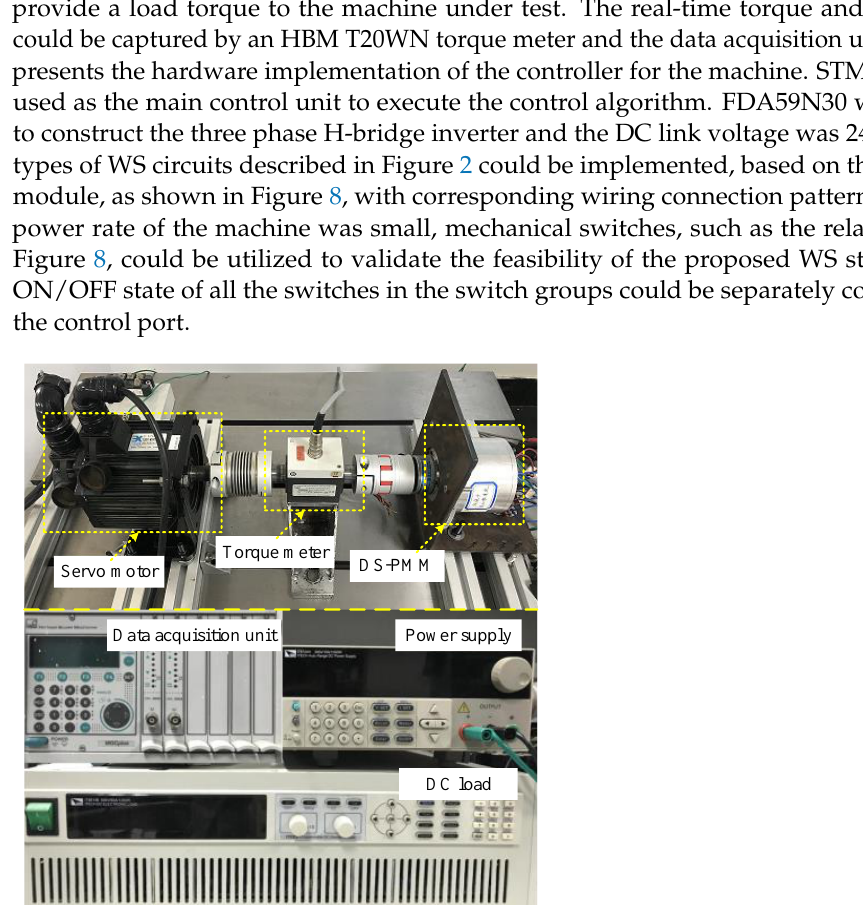
Figure 8. The controller of the investigated DS-PMM using WS strategy. Figure 9 shows the measured no-load back-EMF of the DS-PMM prototype in the three operating modes with different WS circuits. It was found that each winding mode had different magnitudes of back-EMFs. That is to say, the proposed WS strategy could adjust the PM flux linkage of the machine to realize FW and extend the speed range. In addition, it should be noted that the proposed WS strategy for DS-PMM would not lead to the phase shift of back-EMFs in different coils, which was superior to the corresponding electromagnetic performance in [13]. That is to say, no compensation was required for the d -axis position when the WS strategy was applied to the DS-PMM.